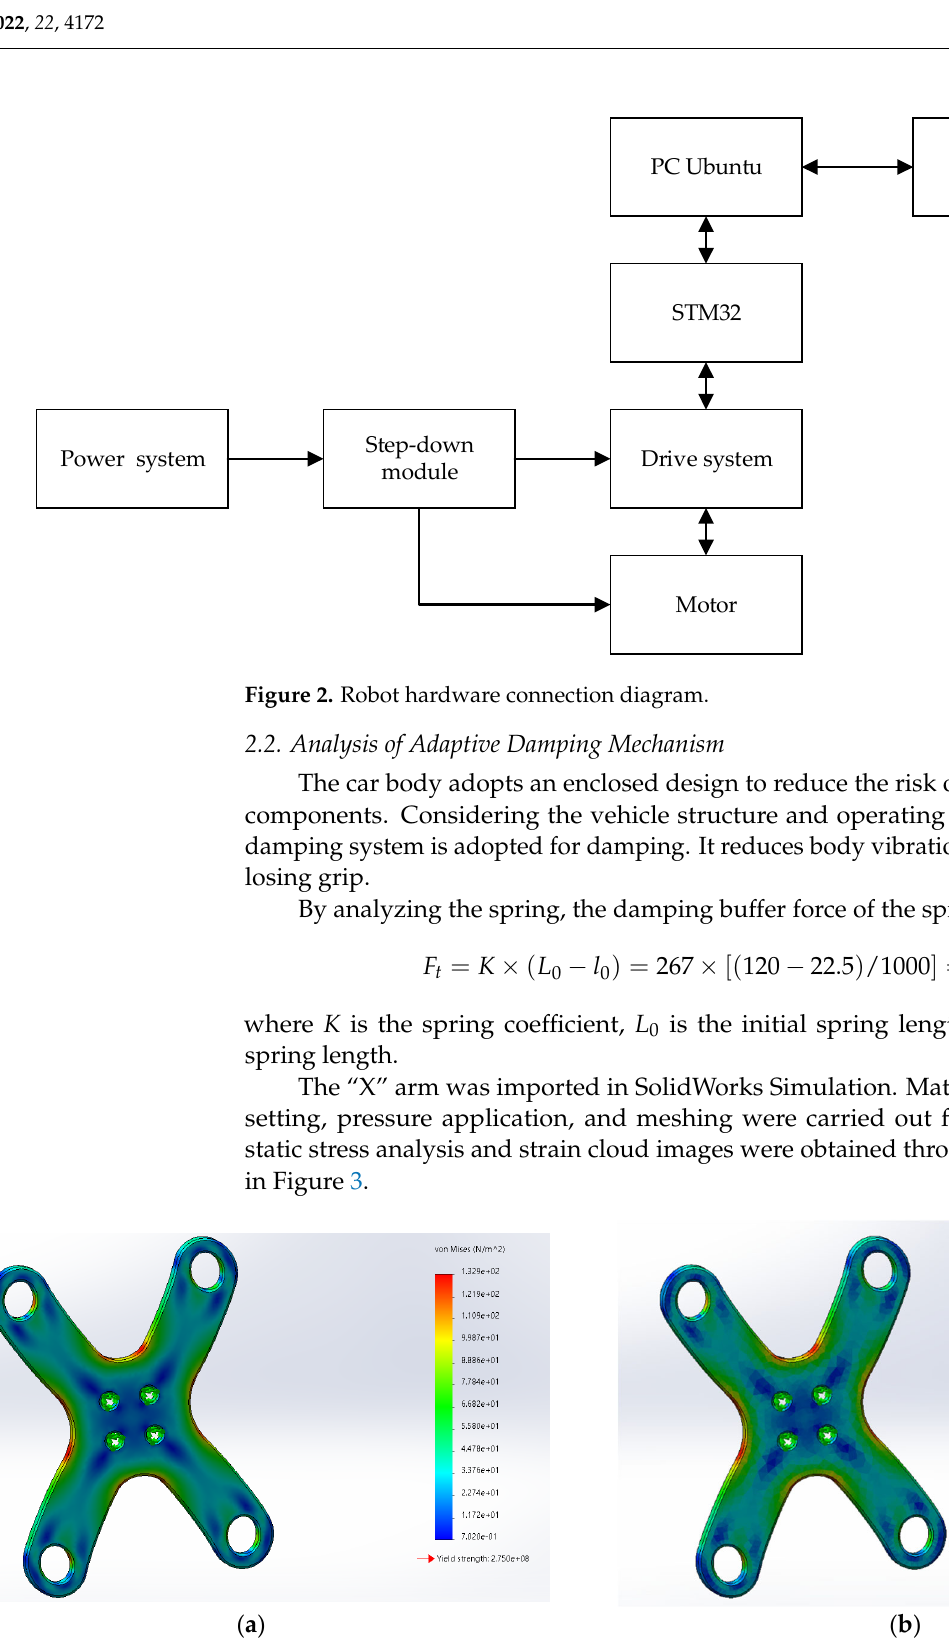
Figure 3. SolidWorks Simulation diagram. ( a ) Static stress figure; ( b ) strain figure.